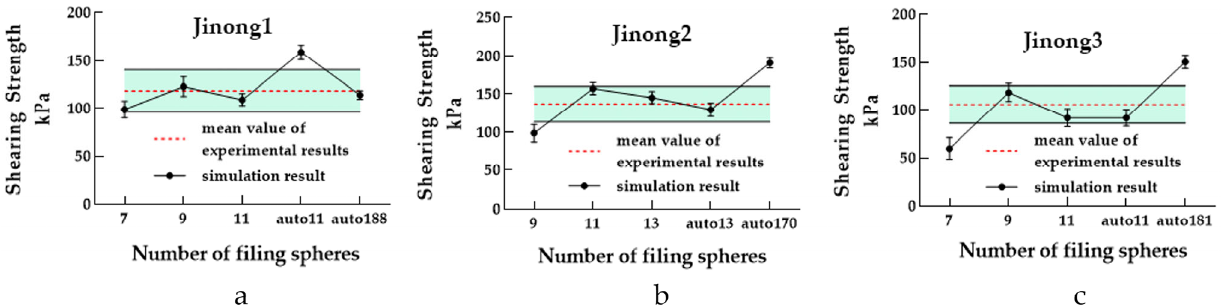
Figure 13. Simulation results of the direct shear test.